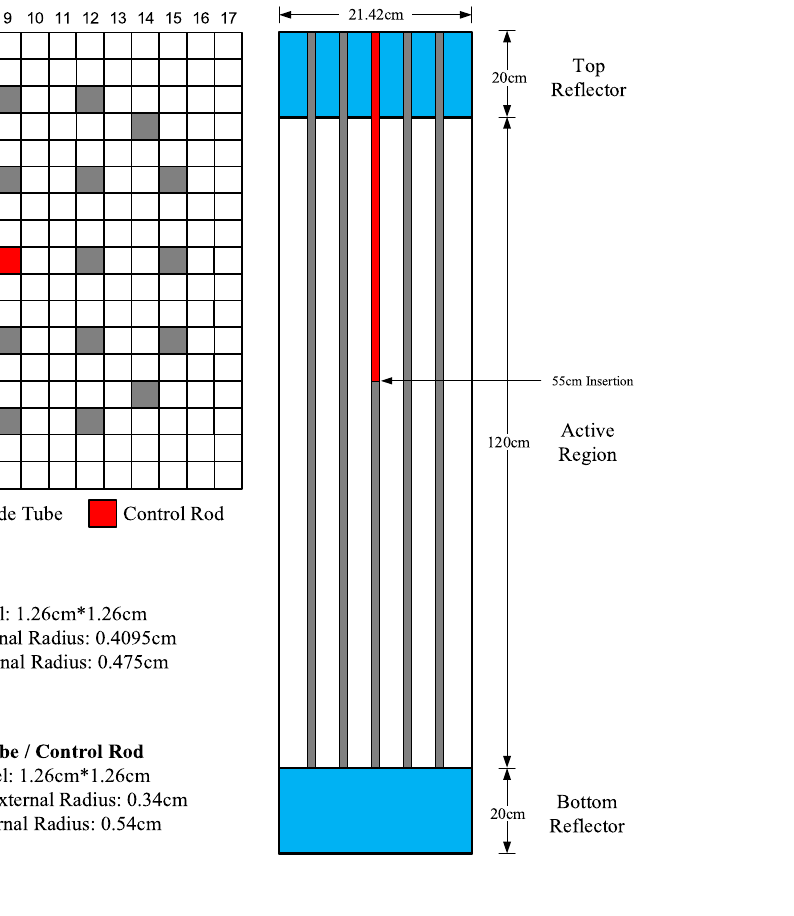
FIGURE 6 | Geometry con fi guration for Problem